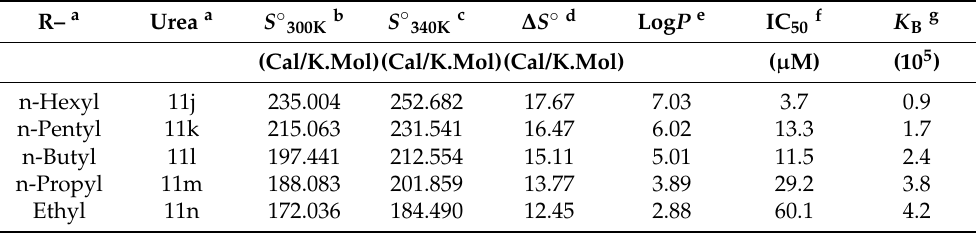
Table 1. Physicochemical and biological data of urea derivatives 11j – 11n .